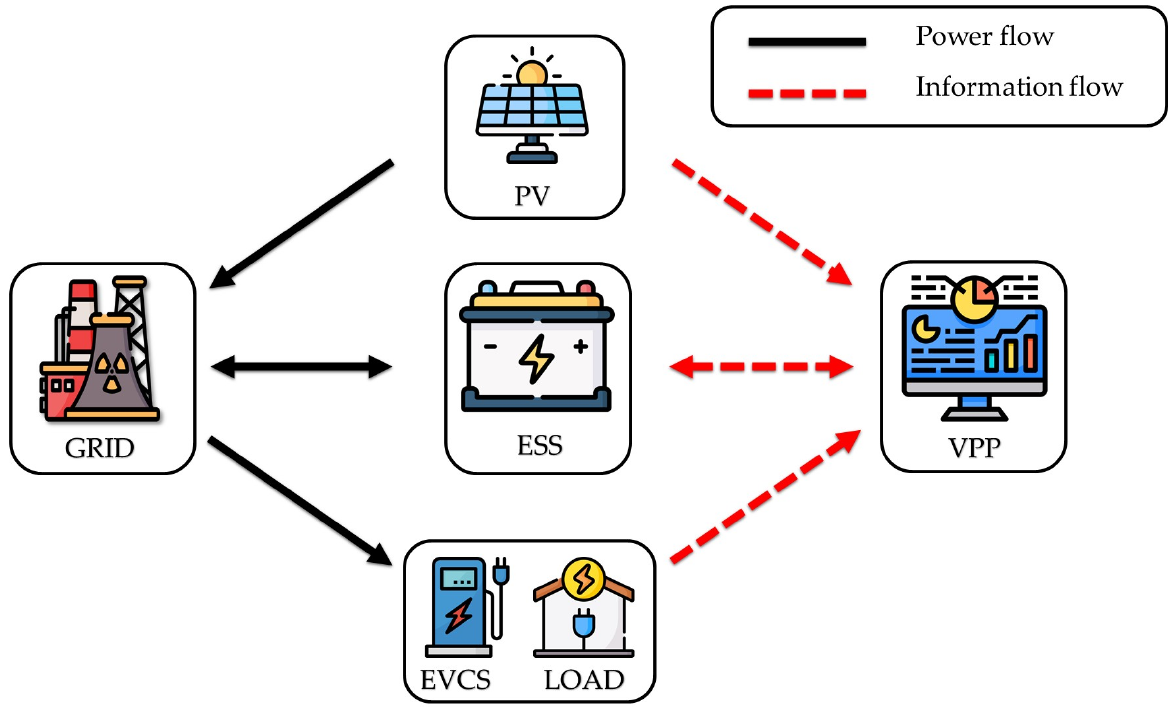
Figure 1. The structure of the VPP model.